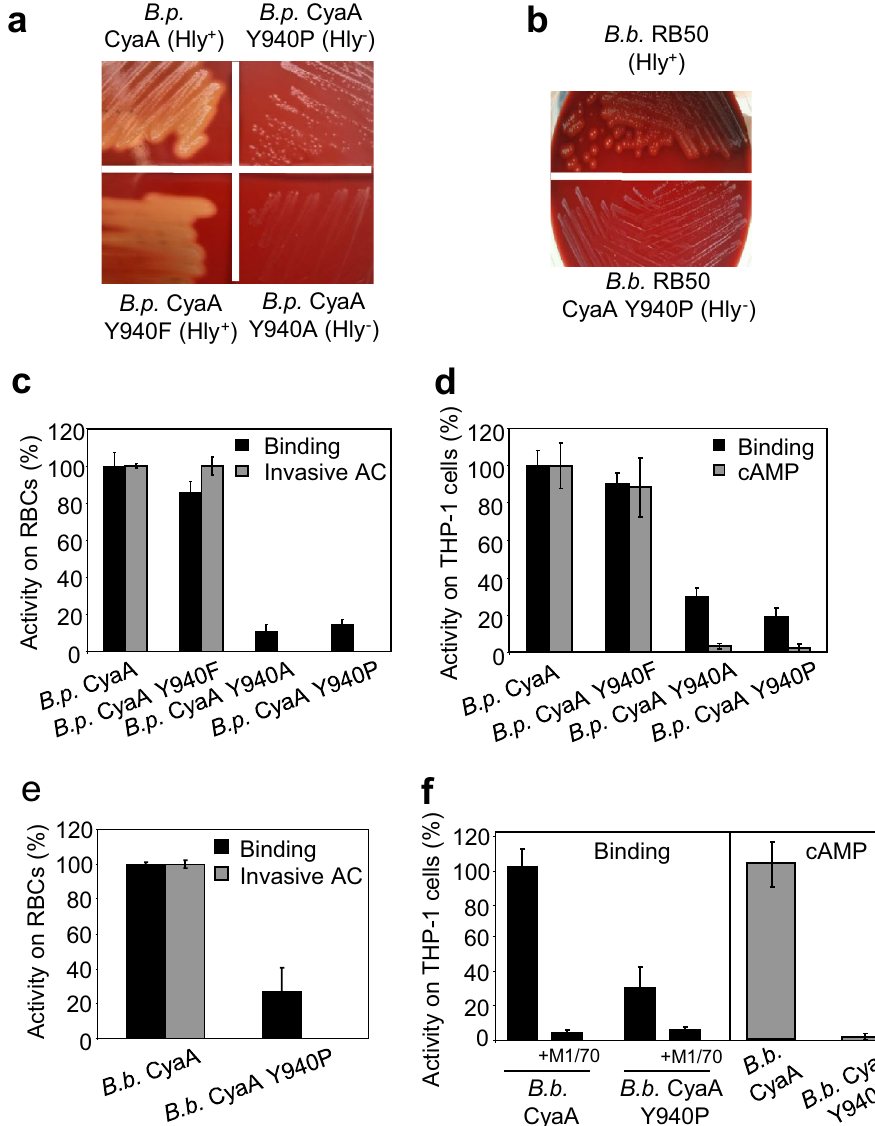
Figure 1. The activity of B. pertussis (B.p.) and B. bronchiseptica (B.b.) CyaA depends on the structural integrity of the acylated segment. ( a ) Parental B. pertussis strain, the fully-hemolytic B. pertussis expressing the CyaA Y904F, and the non-hemolytic B. pertussis expressing the CyaA Y940A or CyaA Y940P were grown on BG agar with 15% defibrinated sheep blood for 5 days at 37 °C. ( b ) The parental B. bronchiseptica RB50 and the non- hemolytic B. bronchiseptica expressing CyaA Y940P were grown on BG agar with 15% defibrinated sheep blood for 2 days at 37 °C. ( c ) Sheep erythrocytes were incubated at 37 °C with urea extracts (20 mU of B. pertussis CyaA/ml). After 30 min, aliquots were taken to determine the cell-binding and invasive AC. ( d ) The binding of CyaAs to THP-1 cells was determined as the amount of cell-associated AC enzyme activity upon incubation of cells with 40 mU/ml of the protein for 30 min at 4 °C. The cAMP concentration was measured in THP-1 cells (10 5 ) after 30 min of incubation with diluted extracts containing 20, 10, 5 and 2.5 mU/ml of CyaA. ( e ) Sheep erythrocytes were incubated at 37 °C with extracts (20 mU of B. bronchiseptica CyaA/ml) and activities were analyzed as above. ( f ) Binding of intact B. bronchiseptica CyaA or its mutant variants to THP-1 cells was determined as above with 20 mU/ml of the protein. To block the CD11b/CD18, THP-1 cells were pre-incubated for 15 min on ice with 5 μg/ml of the CD11b-specific monoclonal antibody M1/70 prior to the addition of the B. bronchiseptica CyaA variants. The intracellular cAMP was measured in THP-1 cells (1.5 × 10 5 ) after incubation with diluted bacterial lysates containing 10, 5, 2.5 and 1.25 mU/ml of CyaA. Activities in panels C, D, E and F are expressed as percentages of intact B. pertussis or B. bronchiseptica CyaA activity and represent mean ± SD of three independent determinations performed in